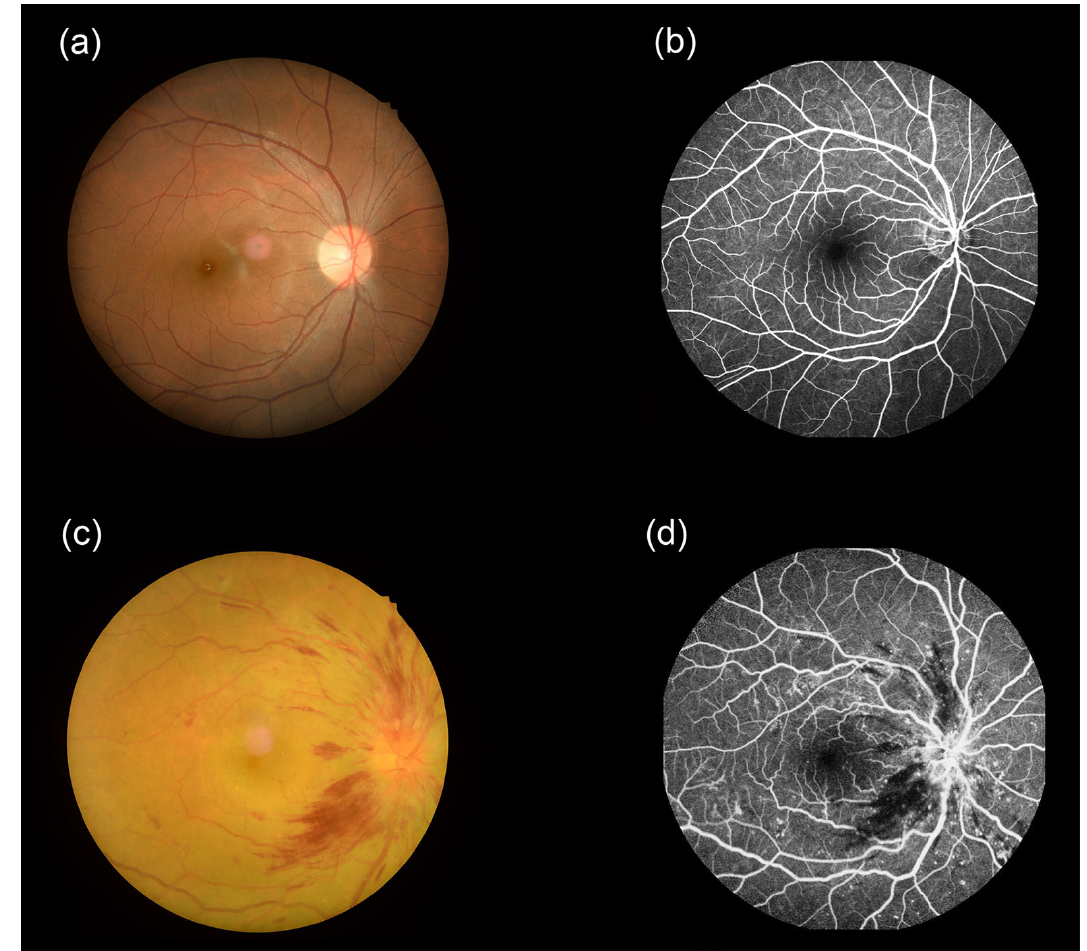
Fig.1. Picturesoffundusexaminations. Retinal fundus photography (a) and fluorescence fundus angiography (b) images of healthy people. Typical retinal fundus photography (c) and fluorescence fundus angiography (d) images in the DON patients. Abbreviations: DON, diabetic optic